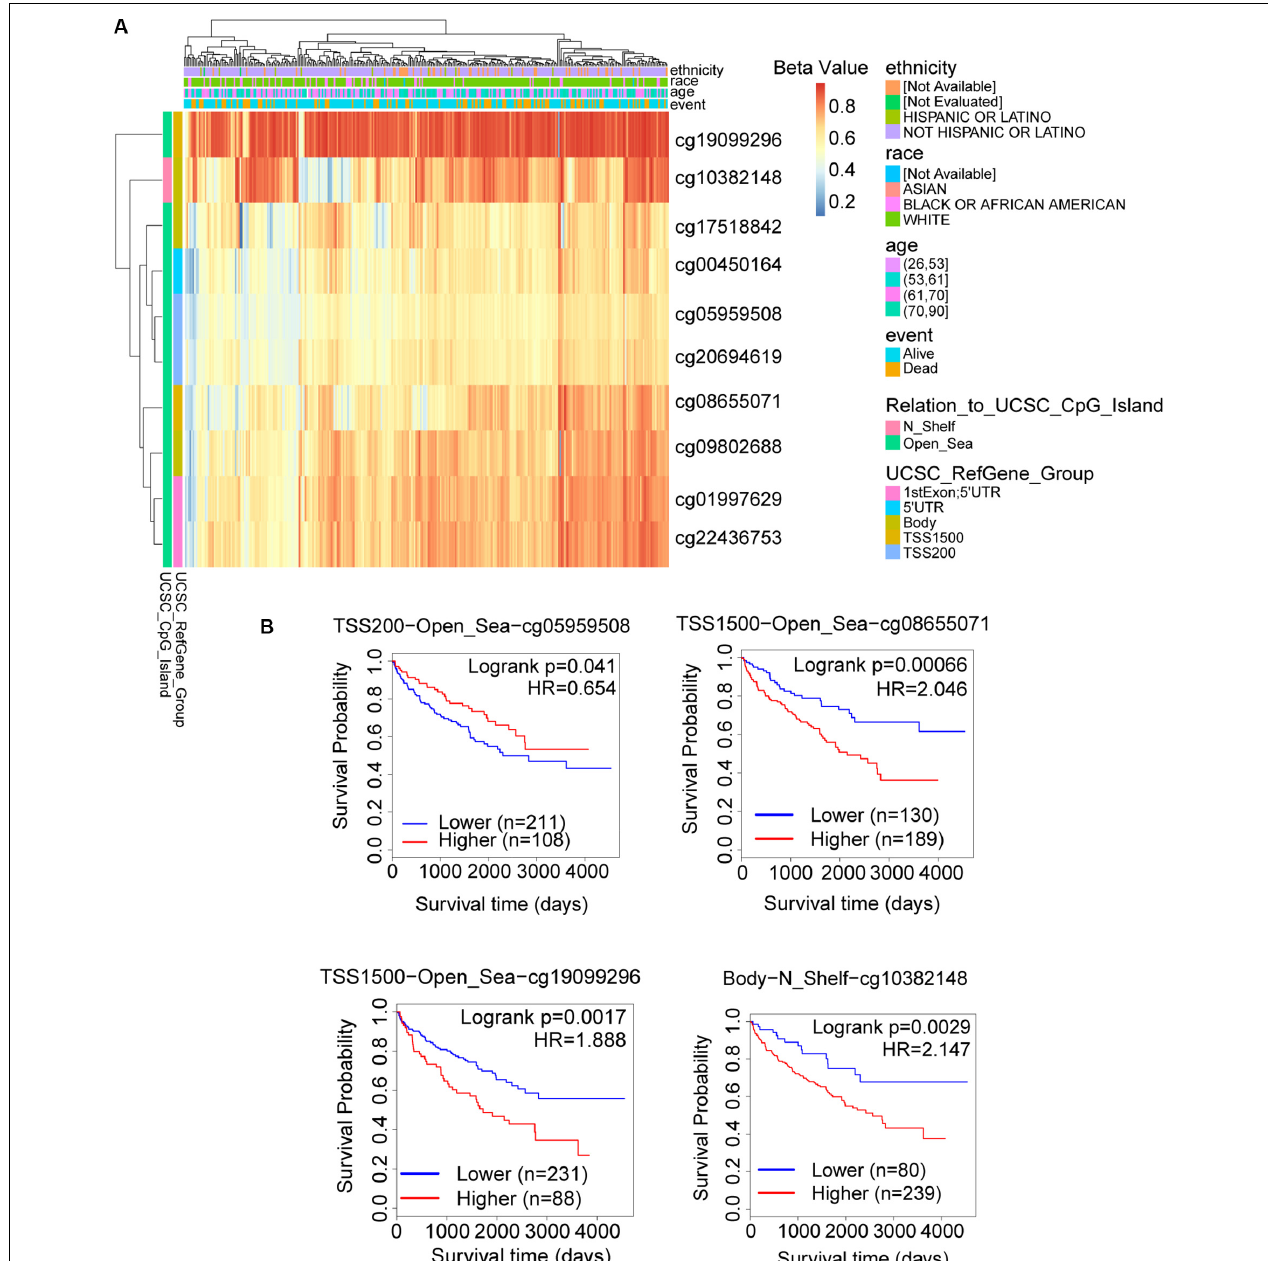
FIGURE 8 | The possible functional site of DNA methylation in TRAF3IP3. (A) The heatmap for methylated TRAF3IP3 in TCGA-KIRC using MethSurv. (B) Kaplan meier plots of single CpG site that had significant prognostic value for TRAF3IP3 in TCGA-KIRC. The Beta value indicates level of DNA methylation, and 0 means unmethylated, and 1 means fully